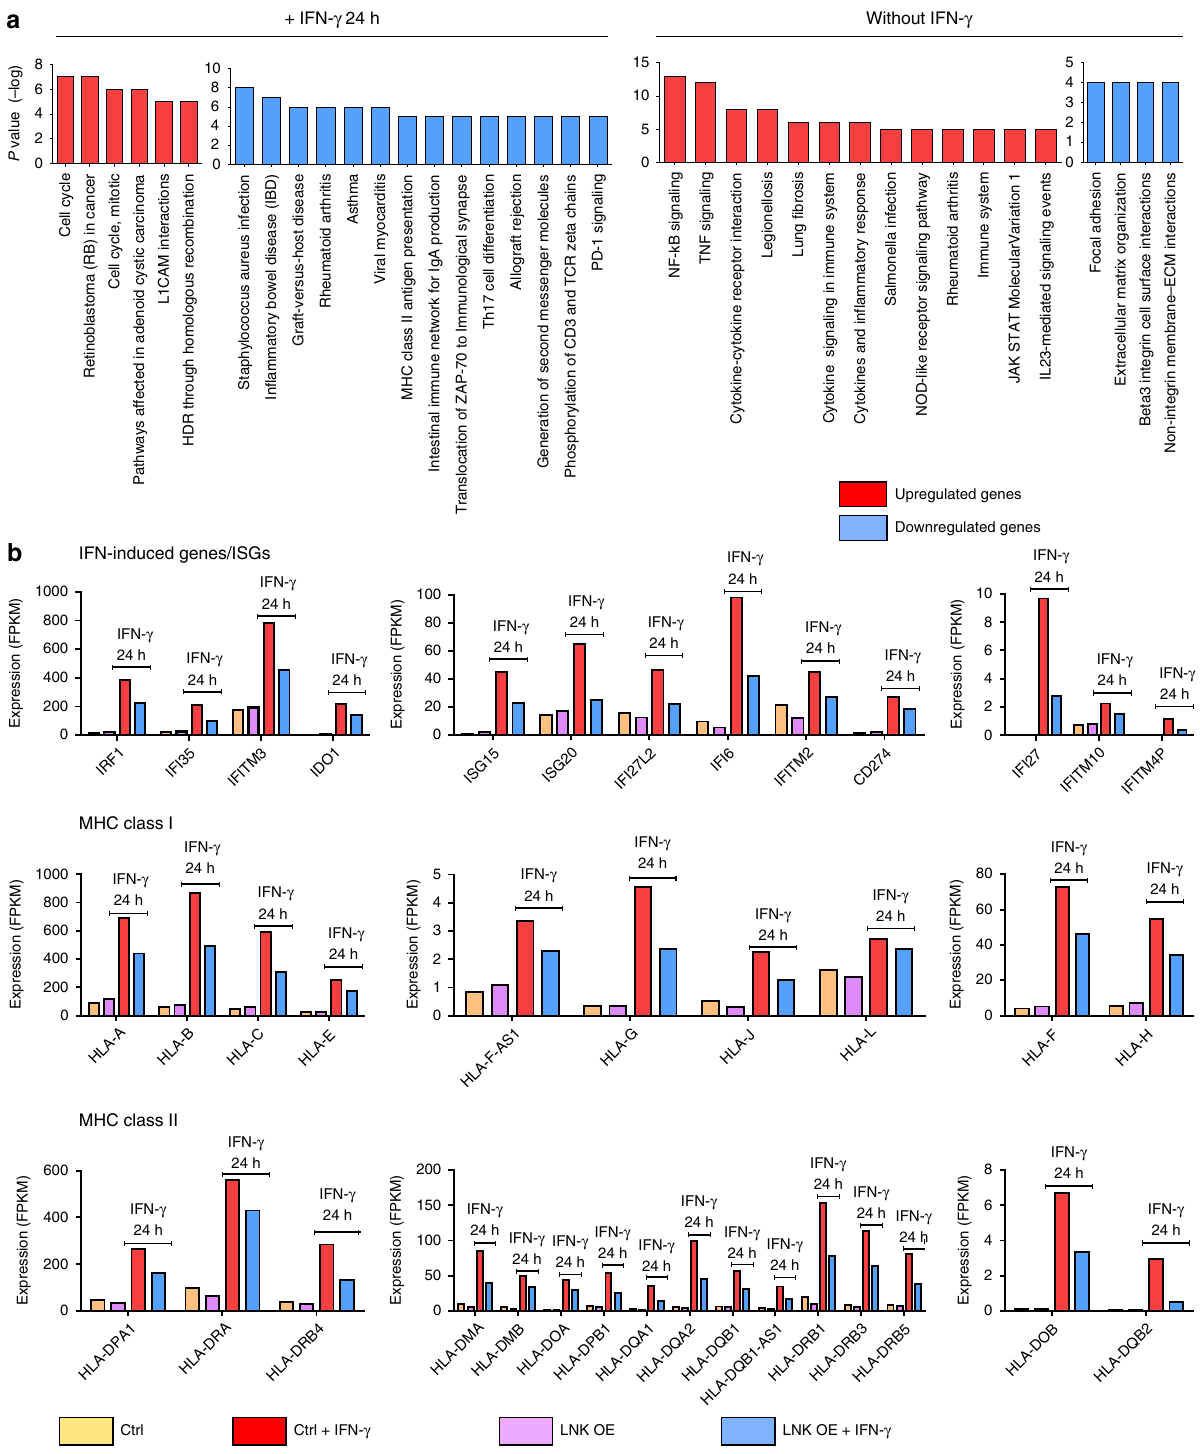
Fig. 4 LNK attenuated the IFN induced gene expression. a Pathway enrichment analysis: A375 cells with forced expression of LNK (LNK OE) were cultured either with (left panel) or without (right panel) IFN- γ (2000 U/ml). Enriched pathways of either upregulated (red color) or downregulated (blue color) genes in forced LNK expressing A375 melanoma cells are displayed with their p value. Pathway analysis was performed using [http://cpdb.molgen.mpg. de/]. b LNK attenuated the IFN- γ (2000 U/ml, 24 h) induced gene expression in A375 melanoma cells. Upper panel, LNK attenuated expression of IFN- γ interferon response genes. Middle panel, LNK attenuated IFN- γ induced expression of MHC class I genes. Lower panel, LNK attenuated IFN- γ induced expression of MHC class II